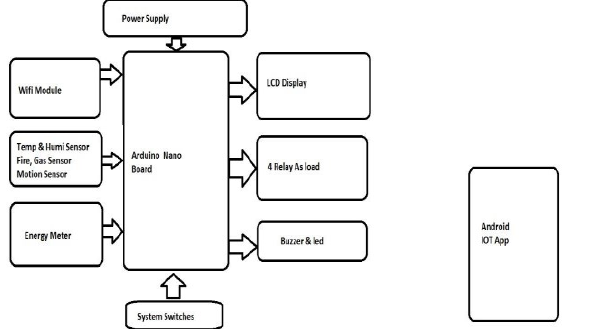
Fig. 10. Hardware model using Arduino connected to the